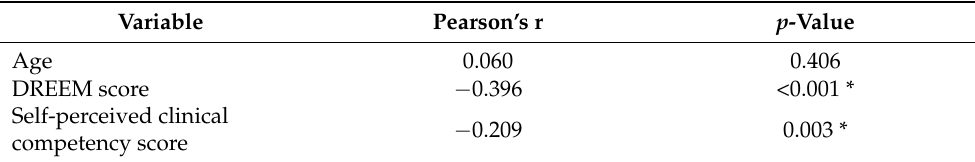
Table 4. Correlations between PHQ-9 score and other continuous variables.